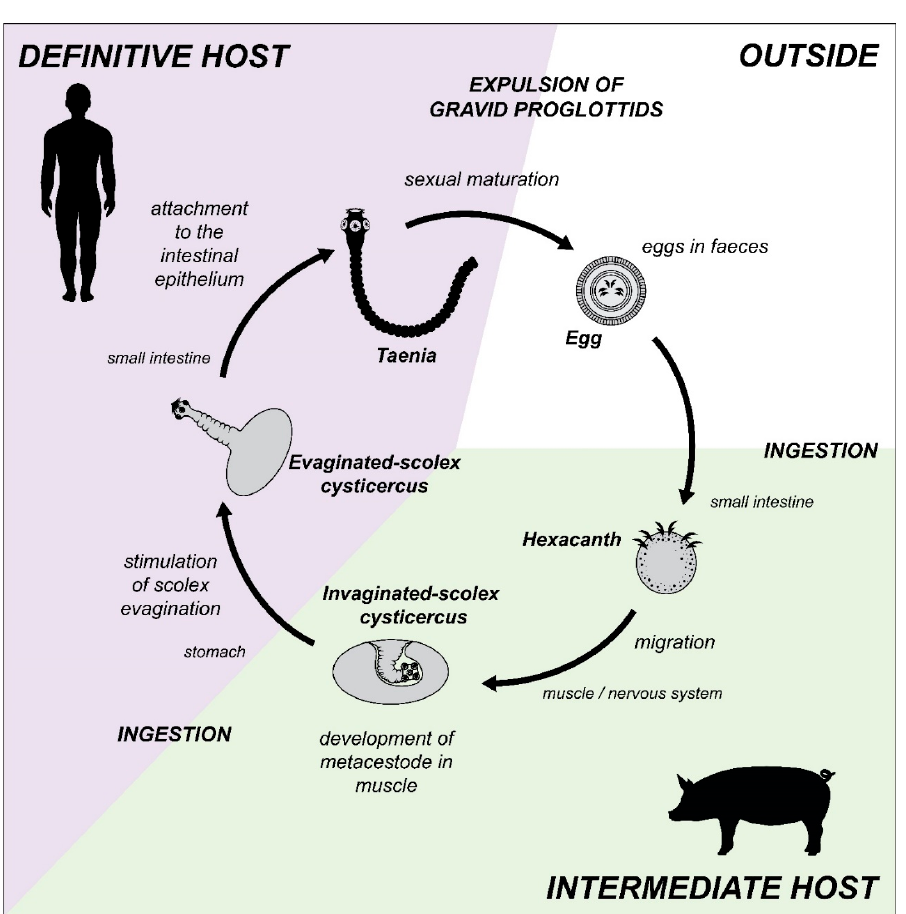
Figure 1. Life cycle of Taenia solium. Parasite stages and its migration through the interior of its intermediate host (e.g., pig, in green) and its definitive host (e.g., man, in purple), is illustrated. Table 1. Oxygen concentration during the life cycle of Taenia solium